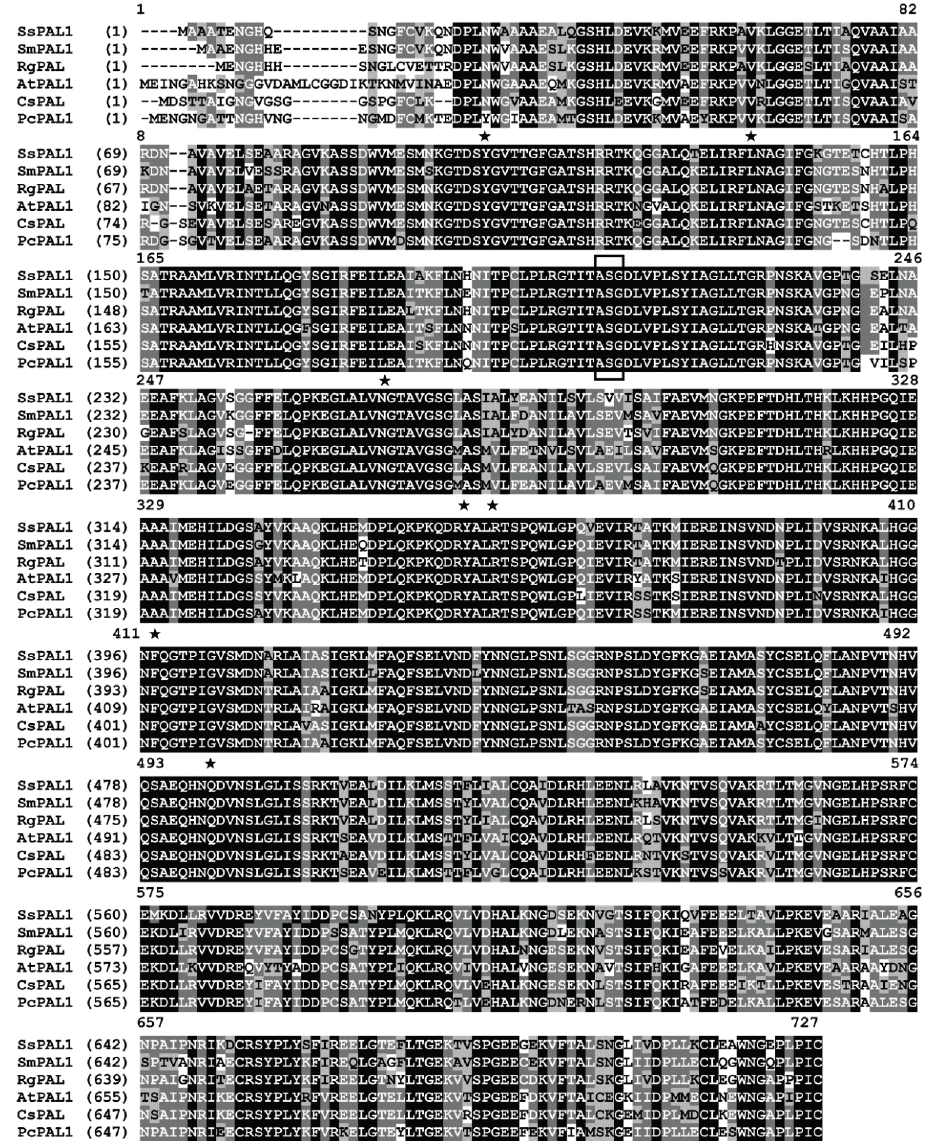
Figure 2. Multi-sequence alignment of SsPAL1 with other plant PAL proteins. The sequences shown here are from Solenostemon scutellarioides ( SsPAL1 , JQ975419), Salvia miltiorrhiza ( SmPAL1 , EF462460), Rehmannia glutinosa ( RgPAL , AAK84225), Arabidopsis thaliana ( AtPAL1 , AY303128), Camellia sinensis ( CsPAL , D26596) and Petroselinum crispum ( PcPAL1 , CAA68938). The highly-conserved Ala-Ser-Gly triad that acts as the active site forming the MIO prosthetic group for non-oxidative deamination is in a box. The conserved active sites are shown by a five-pointed